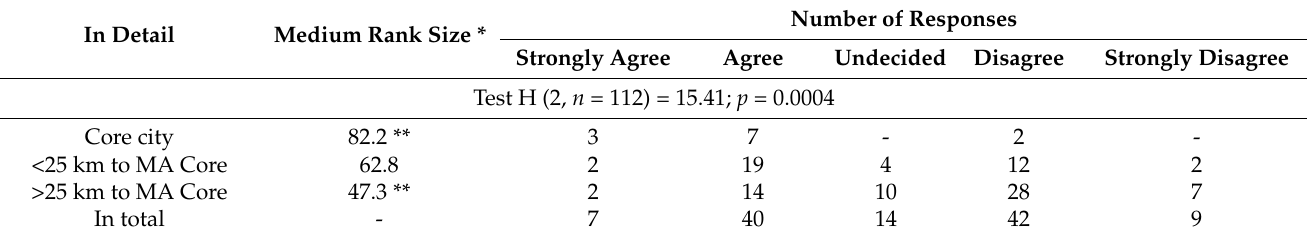
Table 14. Experts’ opinions on growth in the process of farmland abandonment until 2027 ( n = 112). In